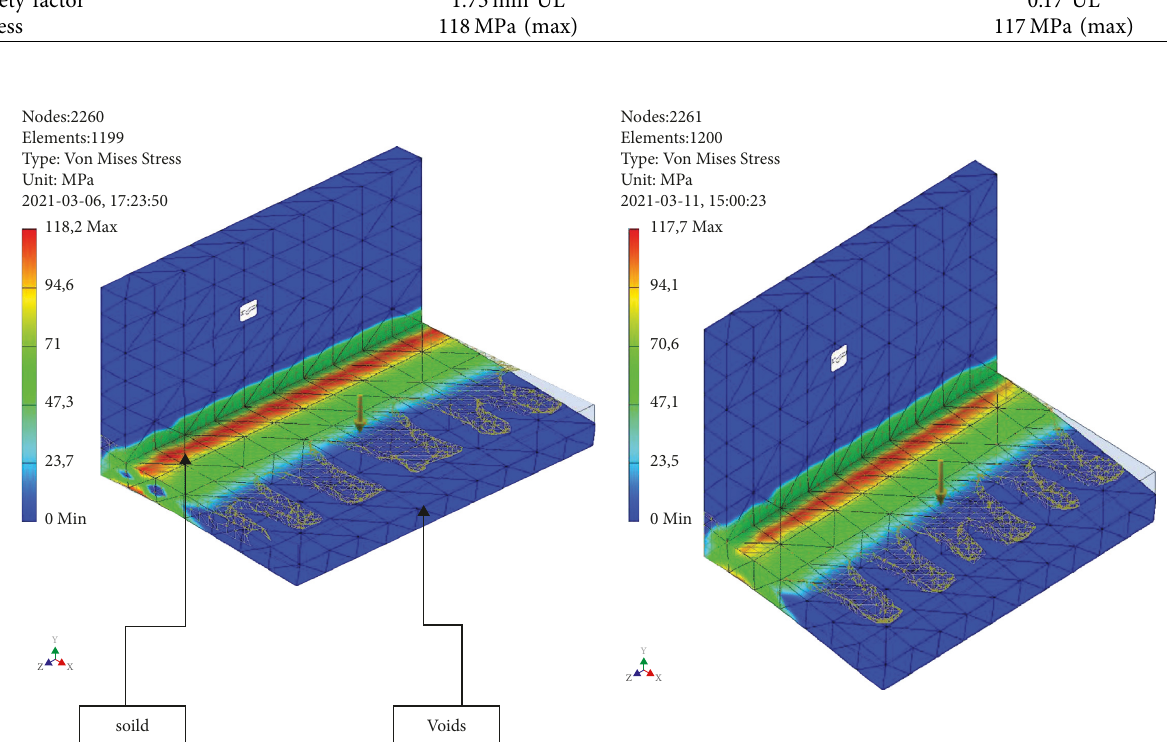
Figure 6: Topology optimized compliant L-clamp plate (mild steel and ABS